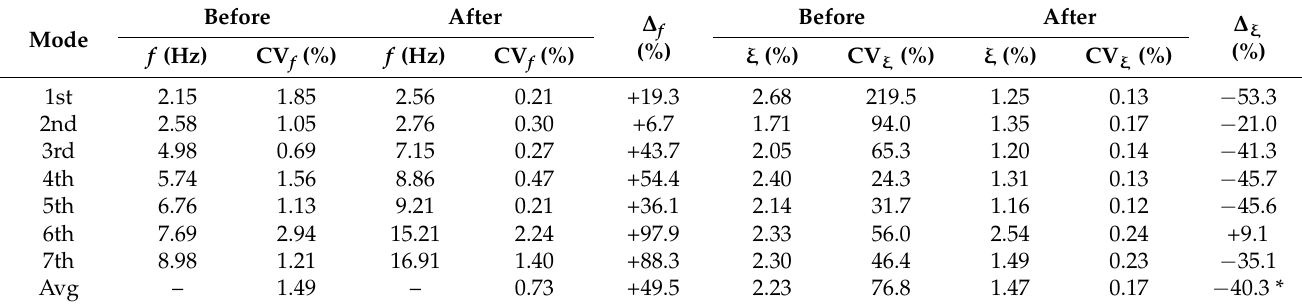
Figure 7. Overview of the Mogadouro tower before, during and after the rehabilitation works. Table 2. Dynamic response of Mogadouro Tower before and after